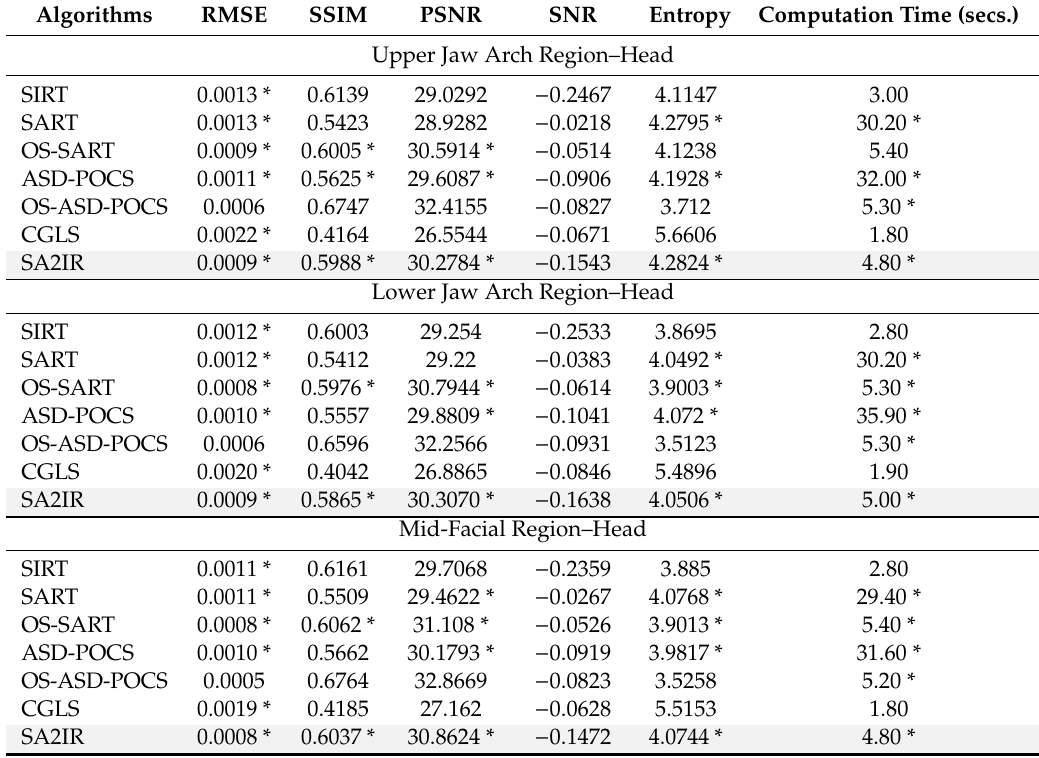
Figure 5. The reconstructed results of others algorithms compared to SA2IR, with respect to the di ff erent anatomical regions, as: ( a )–Upper jaw region (the first row), ( b )–Lower arch (the second row), ( c )–Mid-facial region (the third row), and ( d )–Temporomandibular region (the fourth row). Table 5. Qualitative image quality metric evaluation of the patient data simulation